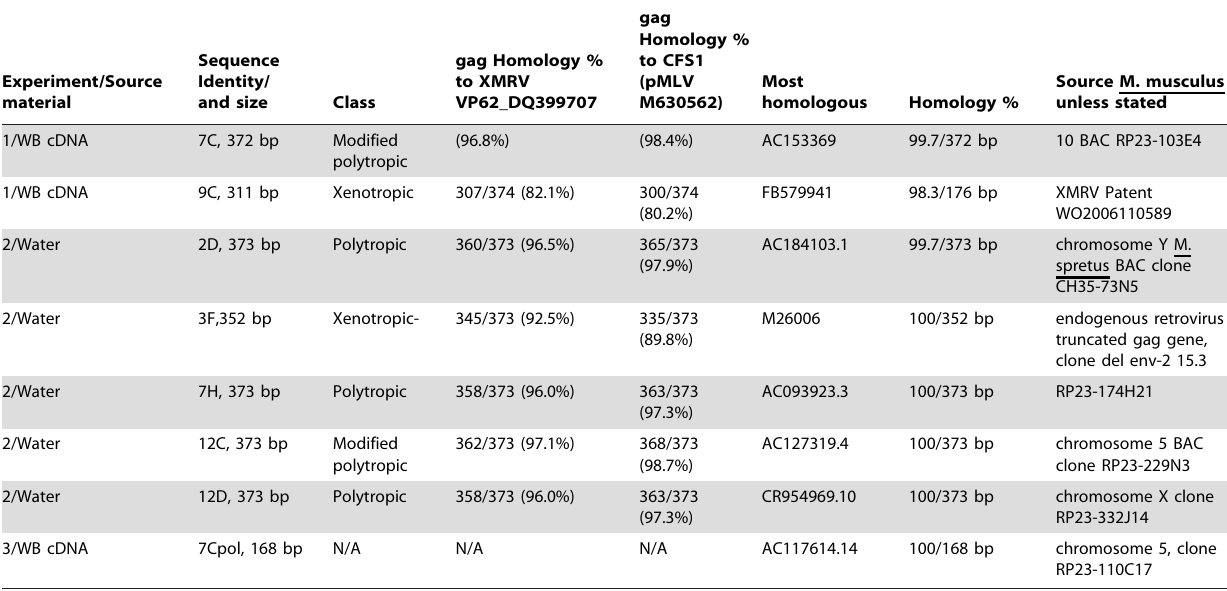
Table 2. Details of sequences